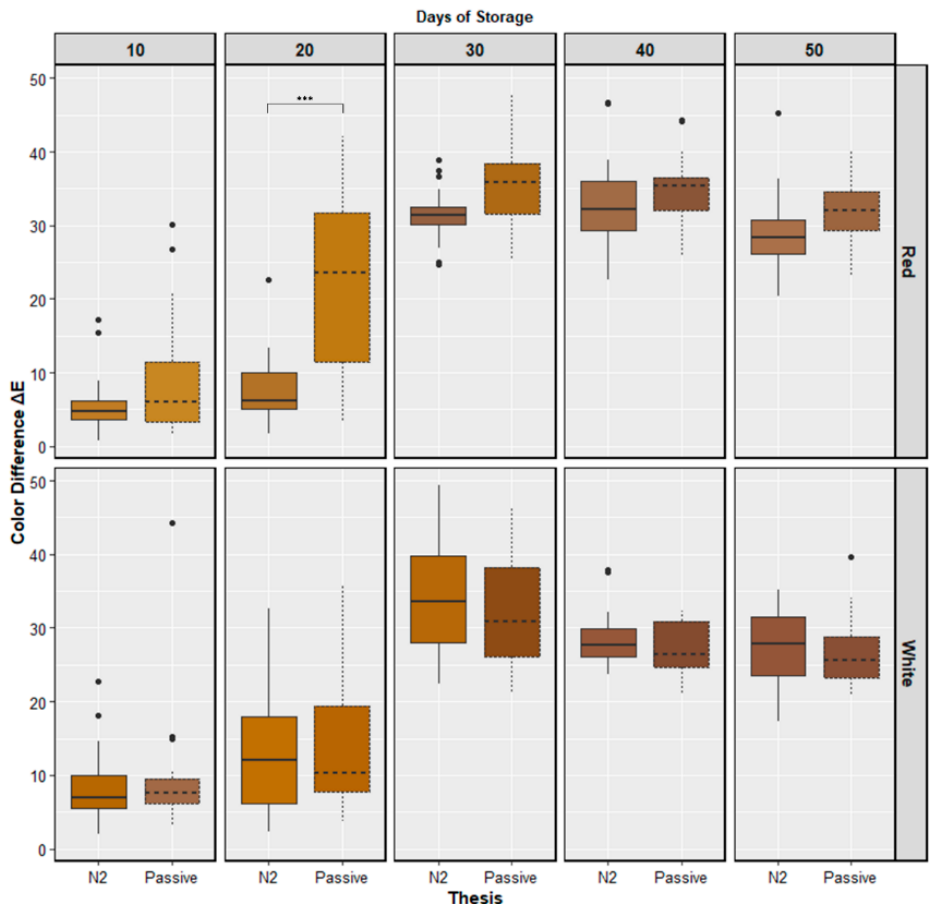
Figure 5. Color difference ( ∆ E ) of the dehydrated loquat slices compared after the various storage times compared to the color measured on the freshly dehydrated slices just after the dehydration process. Box plots are filled with the median color value of the group, transformed from the CIE L * a * b * color space into printable hexadecimal values using the R package color-space. Asterisks between box plots indicate statistical significance of difference using Student’s T-statistic, with *— p < 0.05, **— p < 0.01, and ***— p < 0.001. No asterisk indicates a non-significant difference between the means of the treatments.